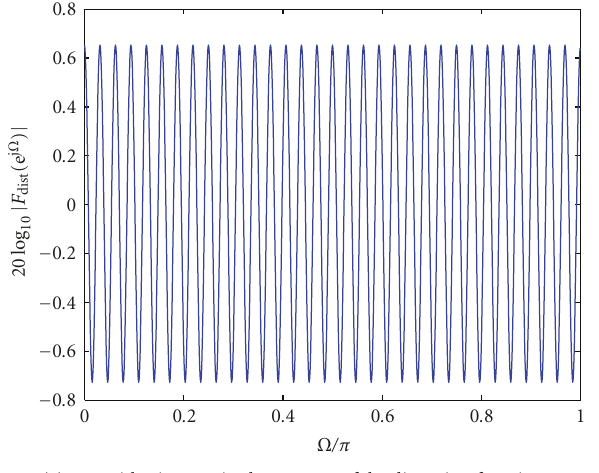
Figure 6: Distortion function in time-domain f dist ( mI